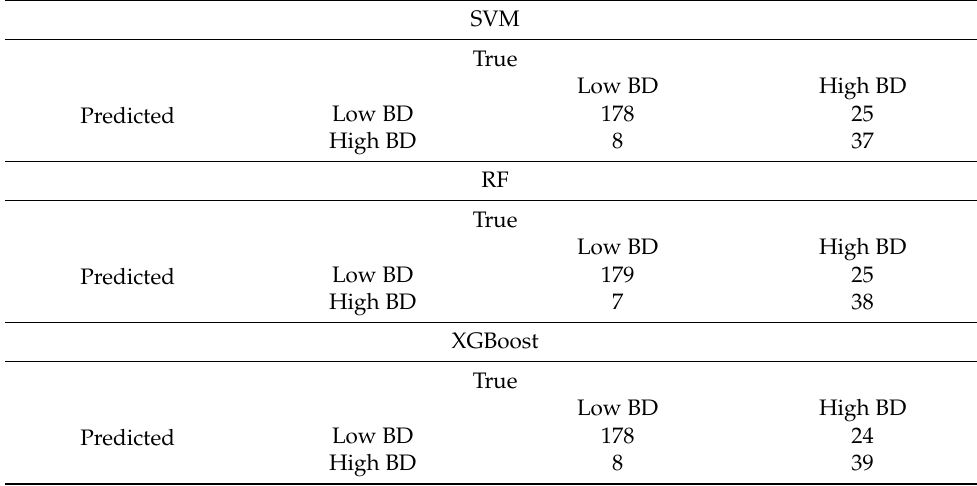
Table 3. Confusion matrix corresponding to the machine-learning algorithms.